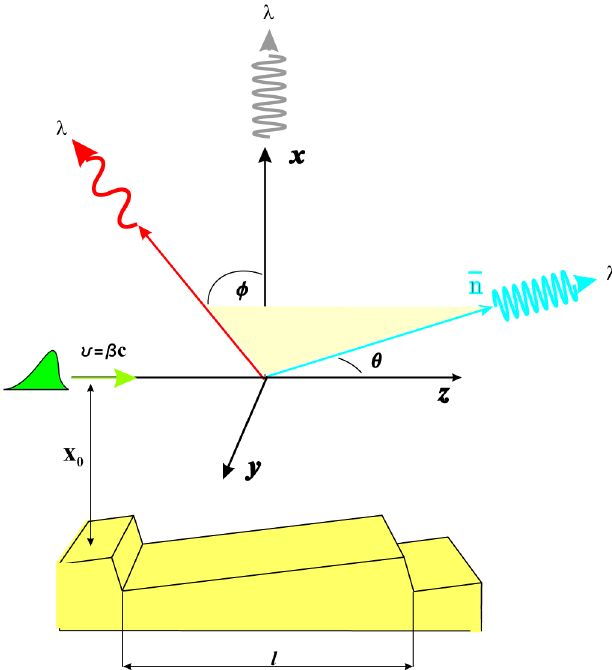
FIG. 1. (Color) Schematic of the Smith-Purcell radiative process and definition of the coordinate